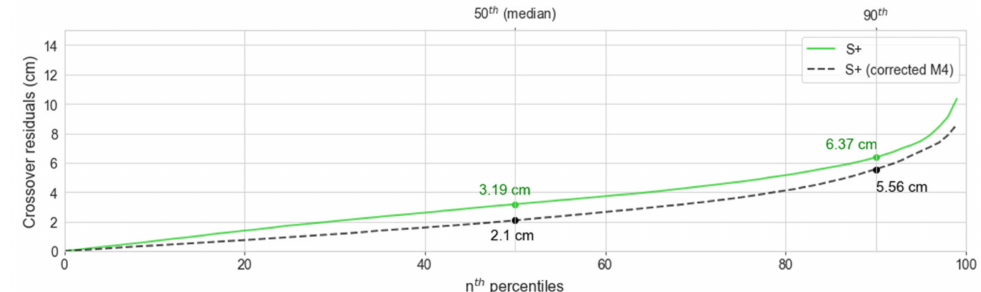
Figure 15. n th percentiles distribution of the crossover residuals, for S+ (green) and S+ empirically corrected from M4 amplitude error (dashed black line). The 50th and 90th centiles are represented by vertical lines, and associated values are displayed for each configuration. Percentiles are computed for absolute values of crossover residuals issued from intra-day and inter-day (excluding the 24 h time